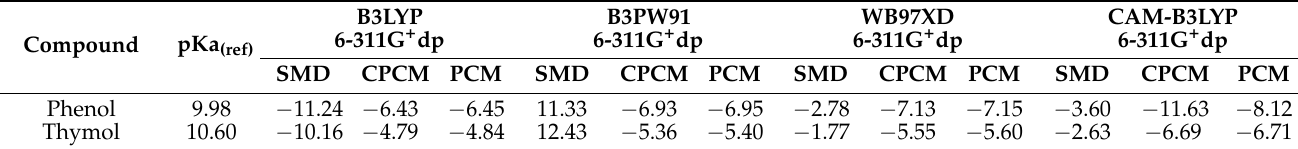
Table 1. ∆ pKa values calculated with no explicit water molecules.